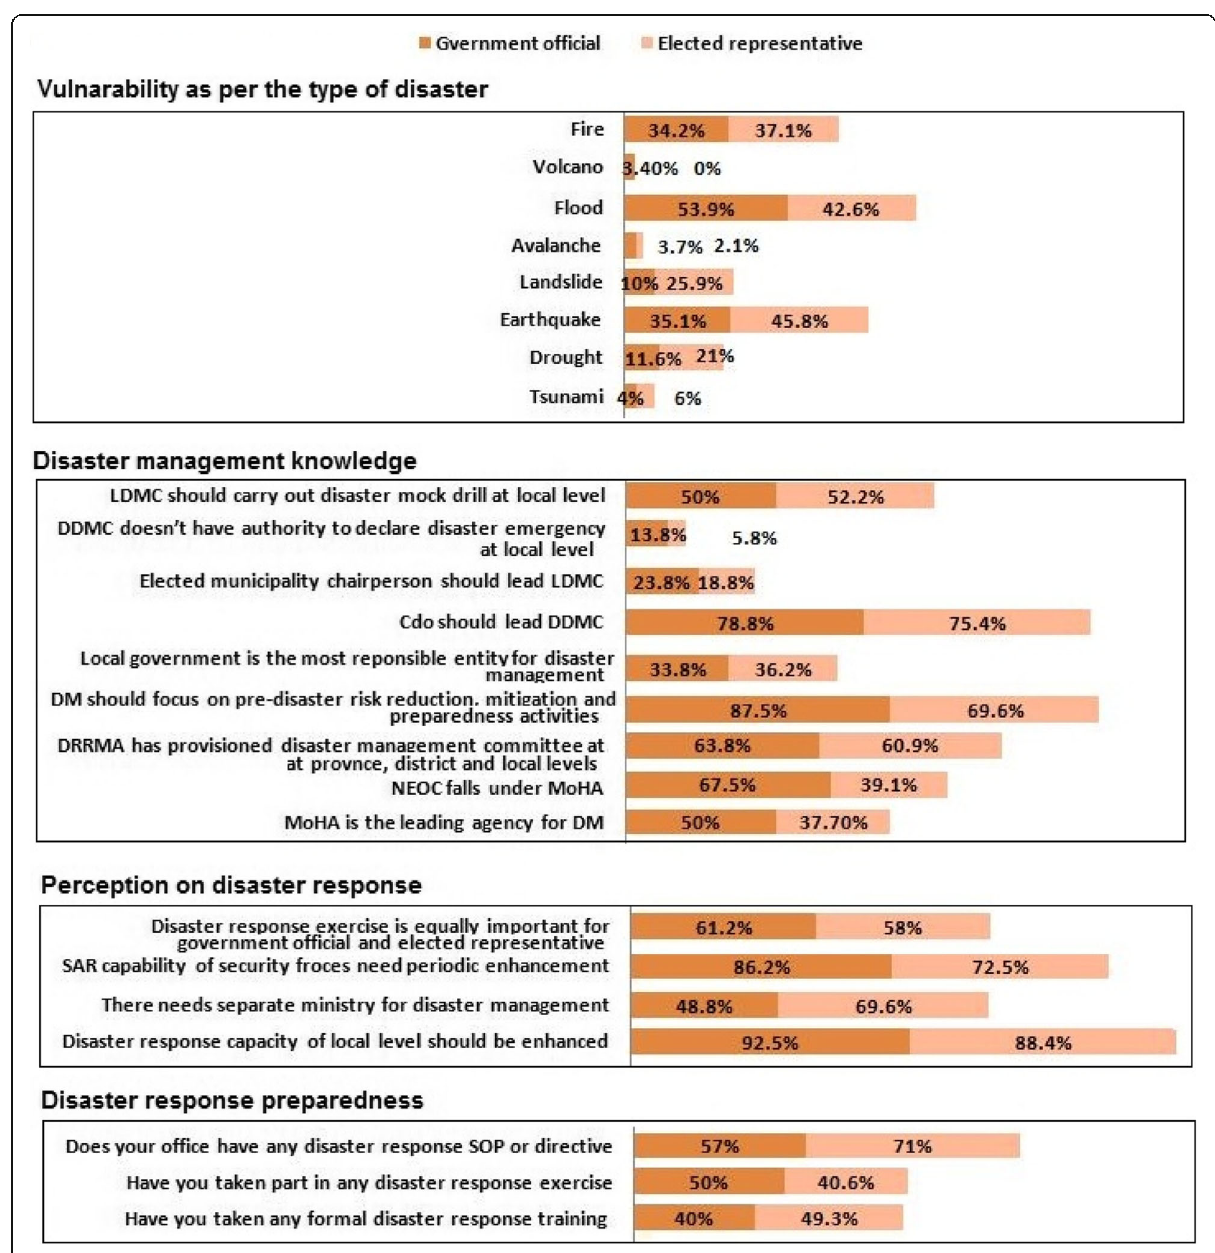
Fig. 7 Comparative study of knowledge, perception and